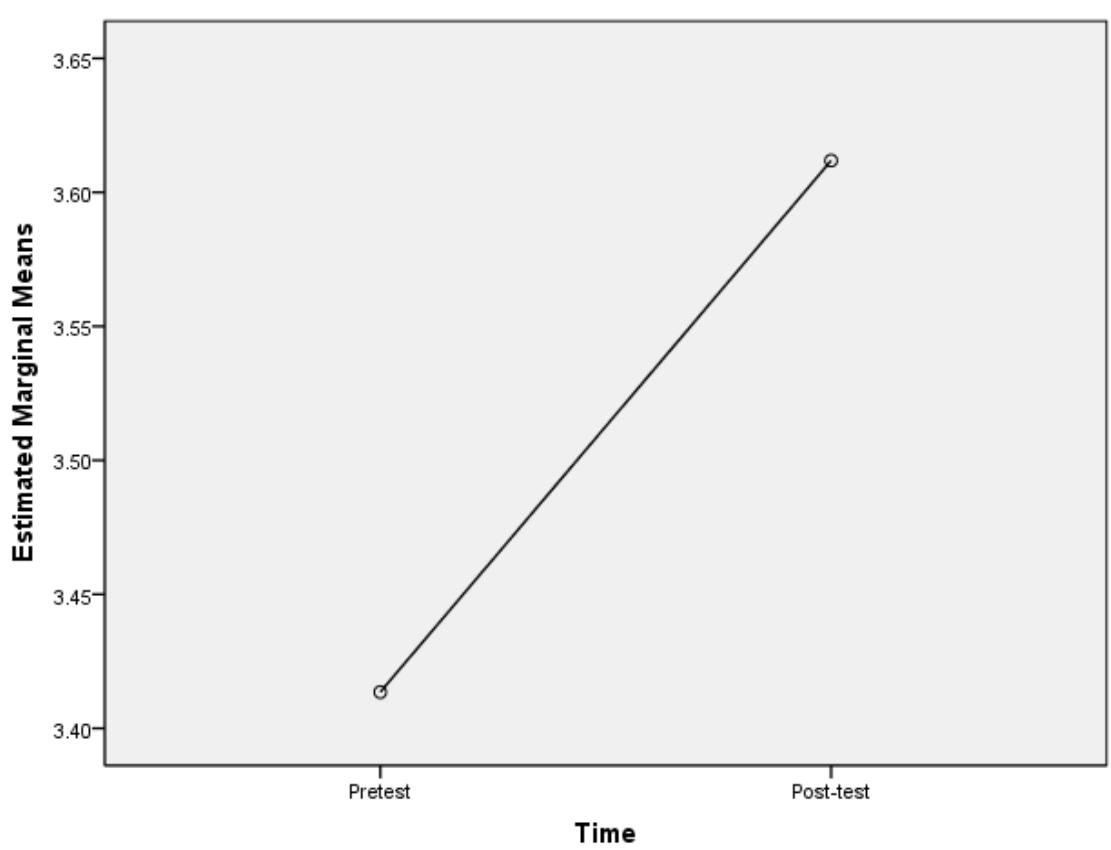
Mean scores of the pre- and post-test data collection intervals, depicting and increase in knowledge after participation in the PEAK